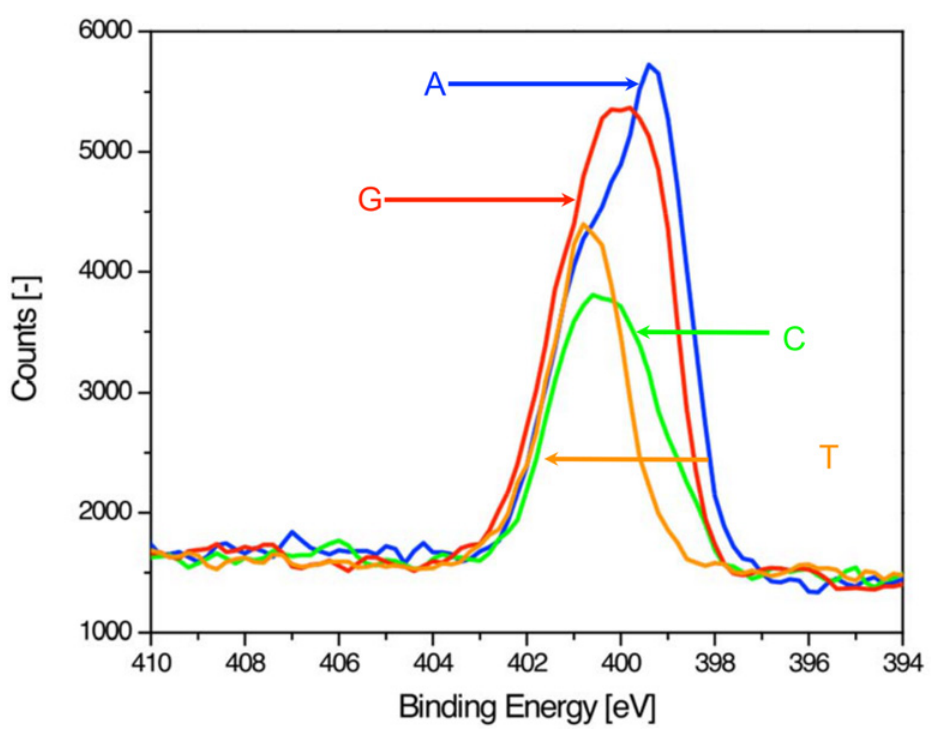
Fig 2. High-resolution nitrogen 1s XPS spectra for single-stranded homopolymeric 20mers.